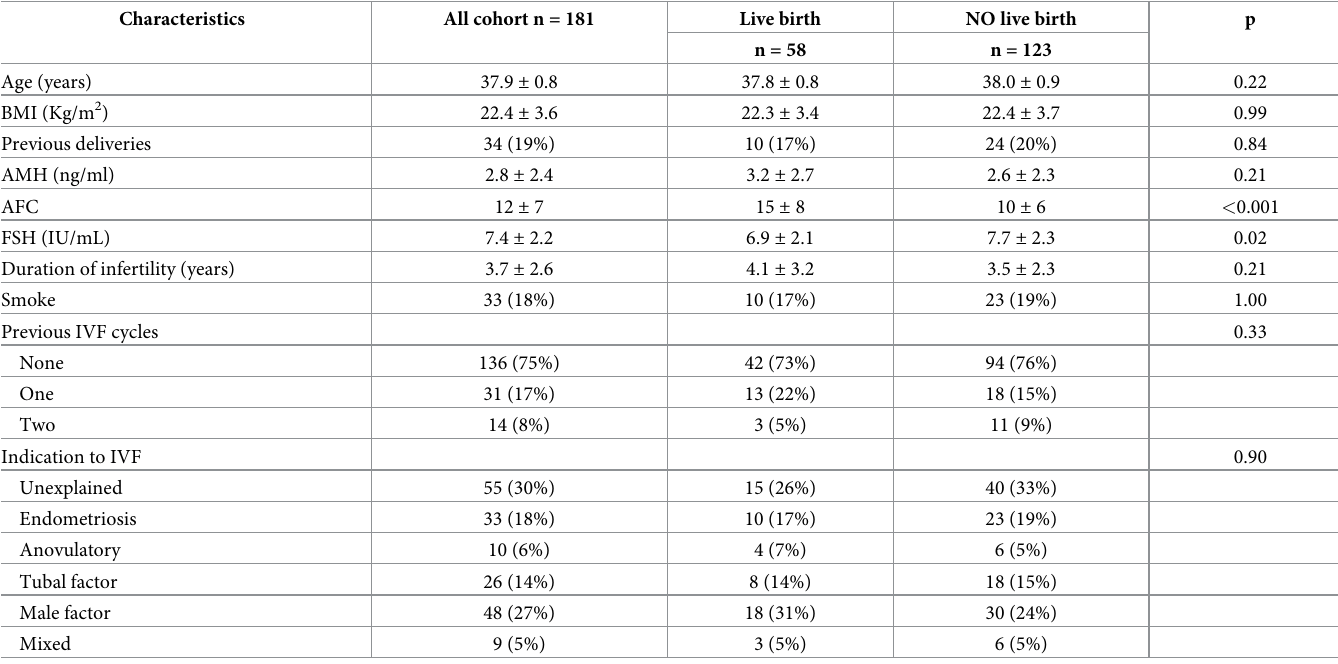
Table 1. Baseline clinical characteristics of the whole cohort and comparison between women who did and did not obtain a live birth. Characteristics All cohort n = 181 Live birth NO live